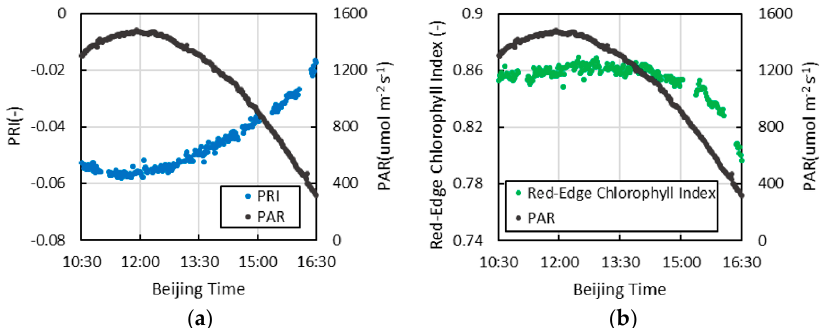
Figure 11. The diurnal variation in the Red-Edge Chlorophyll Index and PRI of sweet potato and the diurnal variation in PAR; ( a ) Red-Edge Chlorophyll Index; ( b ) PRI. In the short term, the PRI value is linked to the xanthophyll cycle of the photo-protection